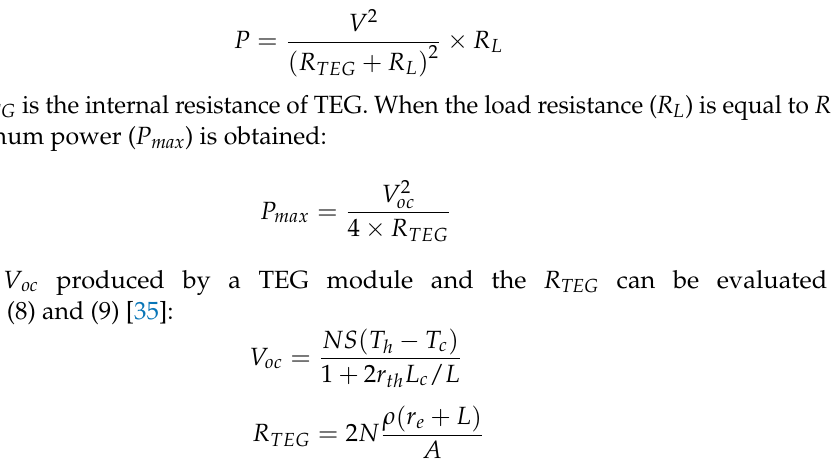
and electrical conductivities of the p-type and n-type TE materials are